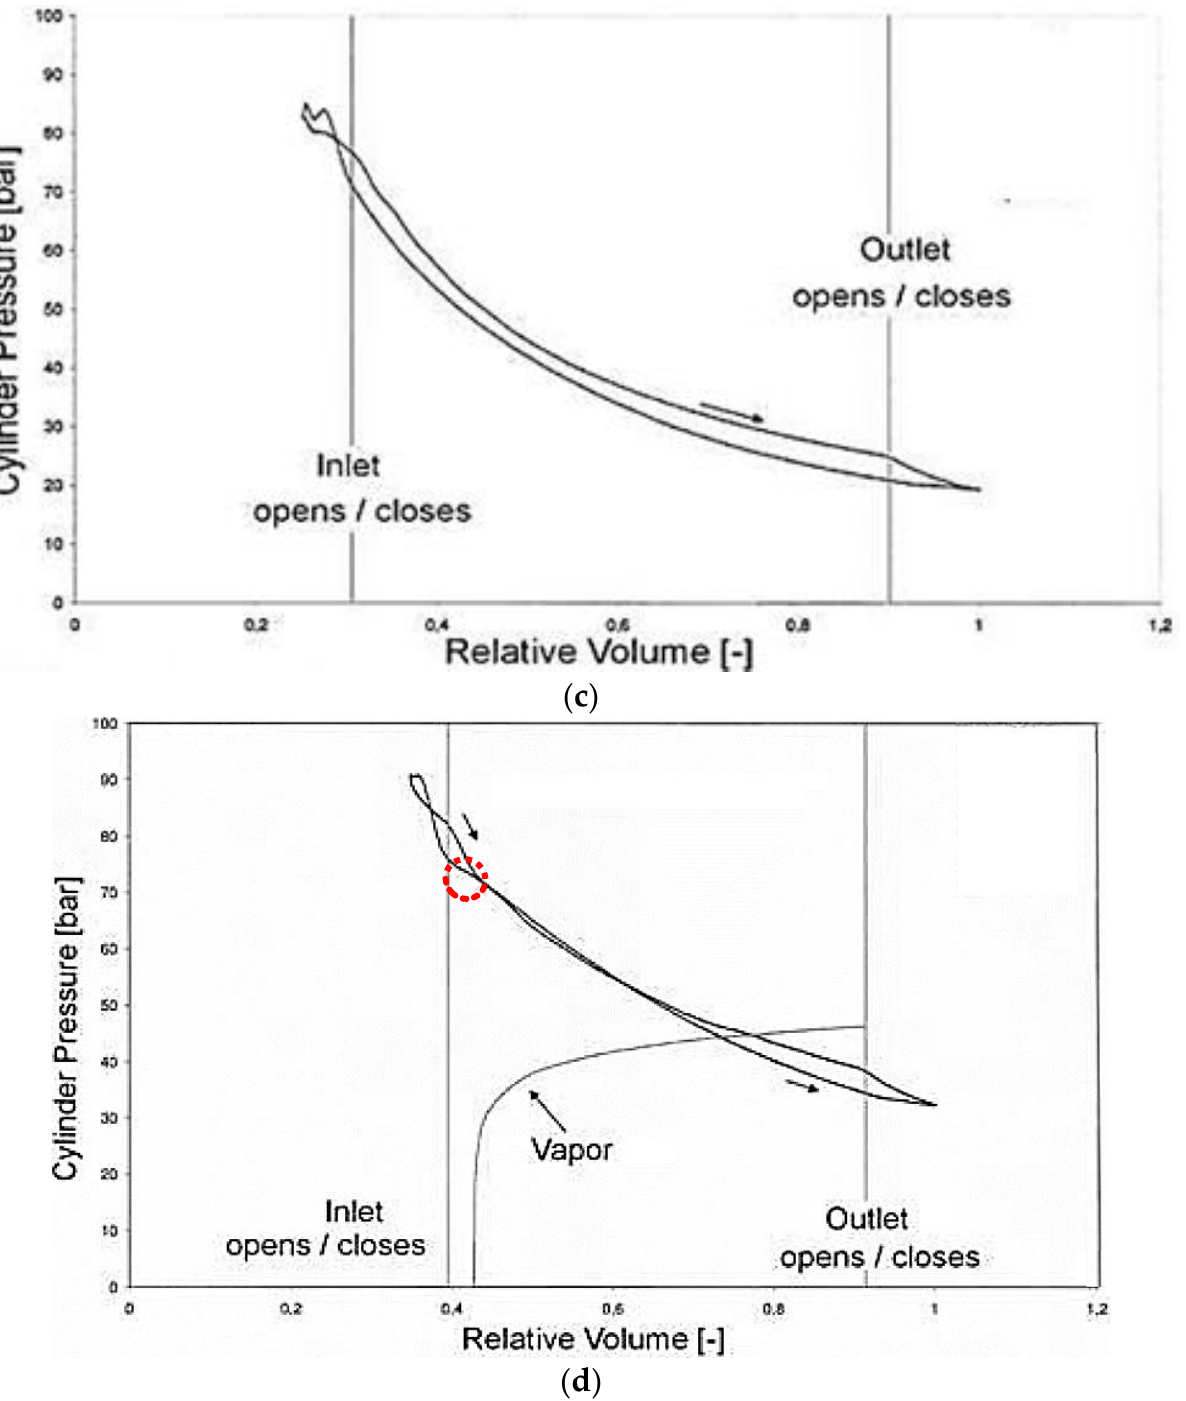
Figure 3. Expansion process on the right and left hand side of the critical point performed by a volumetric machine (reprinted from [6]): thermodynamic diagram ( a ), indicated cycle for the line B ( b ), indicated cycle for the line C ( c ), and indicated cycle for the line D ( d ) with the sharp pressure drop due to the presence of a liquid (in the dashed circle).